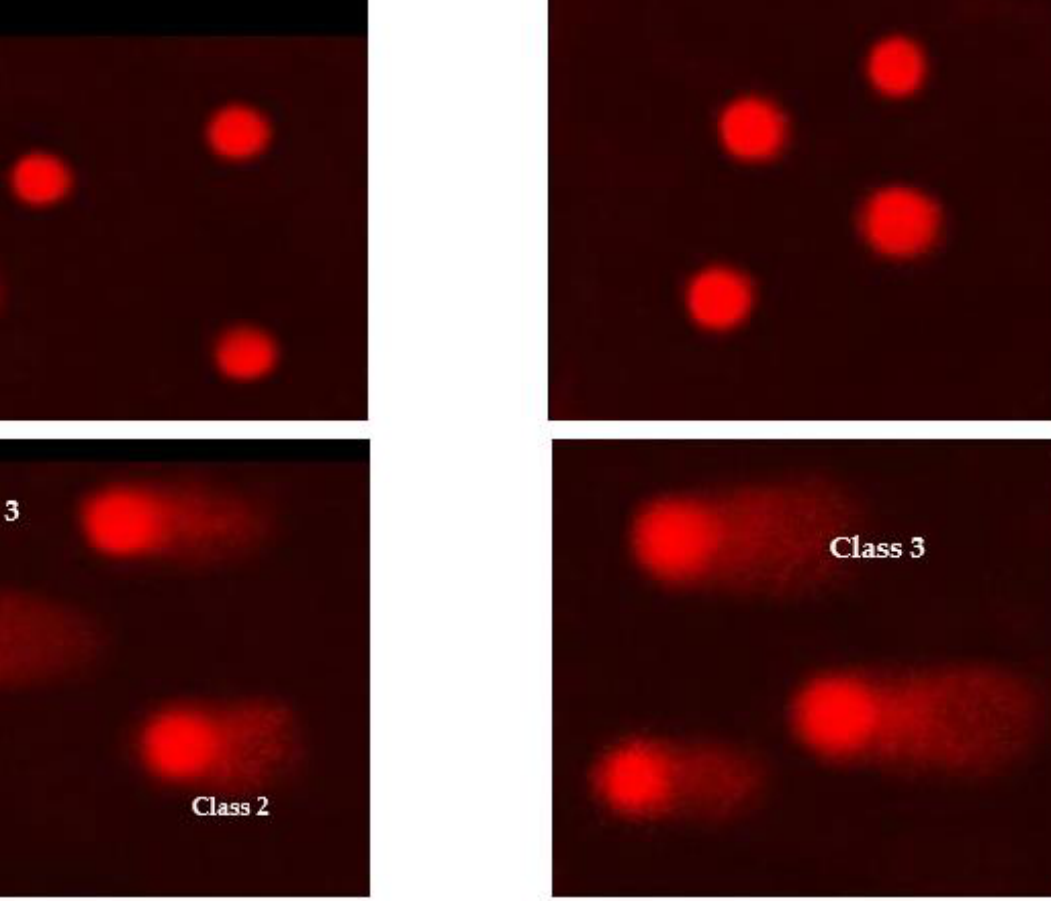
Figure 7. Visual score of normal DNA; ( A ) class 0 and damaged DNA ( B ) class 1, ( C ) class 2 & 3, and ( D ) Class 3 using comet assay in skin cell lines.